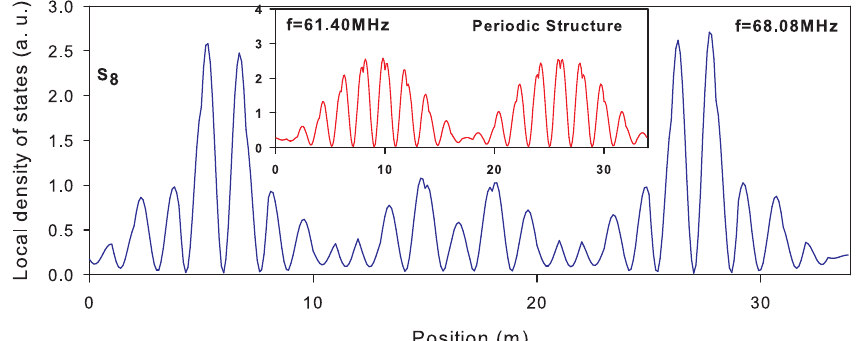
Figure 5. The local density of states (LDOS) [in arbitrary units] as a function of the space position x of the mode located at the band edge ( f = 68.08 MHz) for the 8th generation. The inset of the figure corresponds to the LDOS associated with the periodic structure of length 34 m at f = 61.40